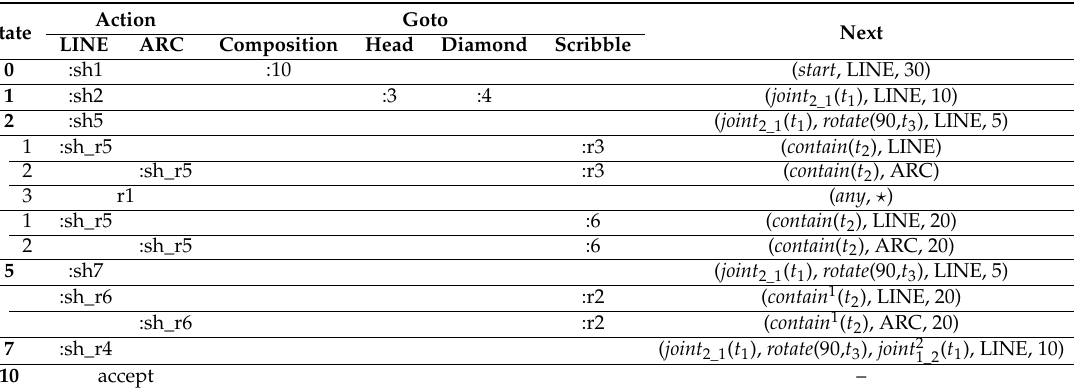
Table 1. Parsing table for Composition grammar.